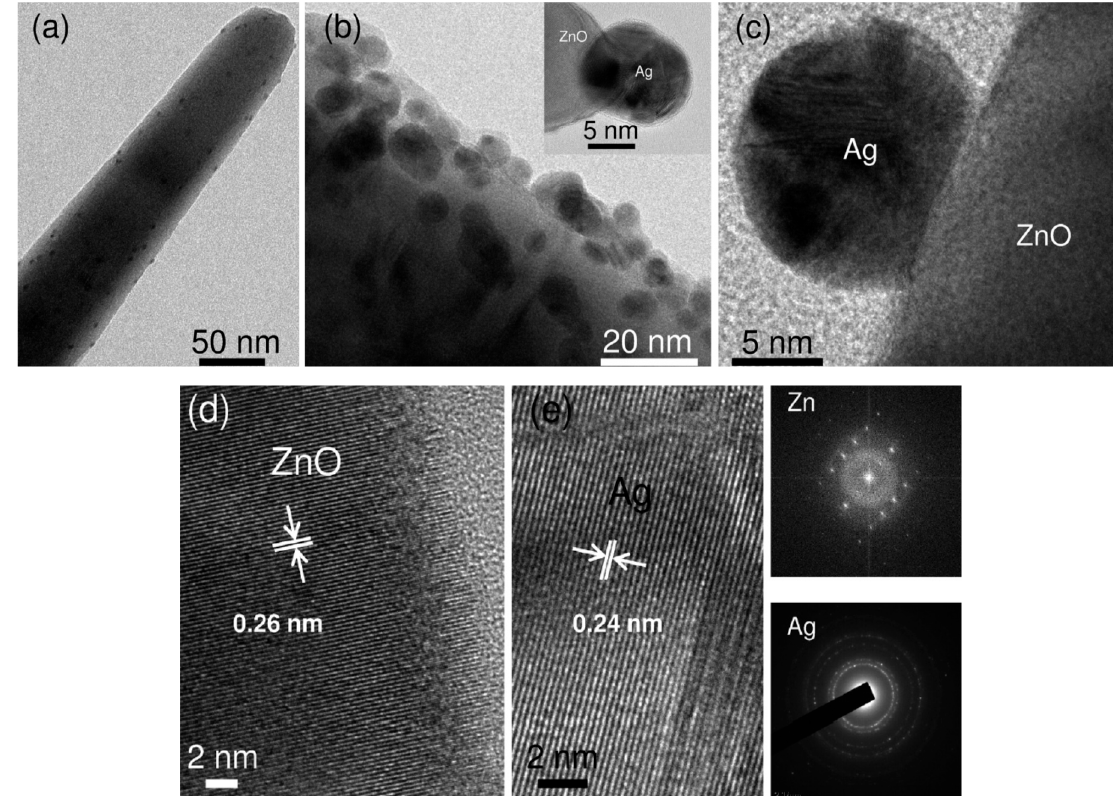
Figure 20. TEM images of ( a ) a single ZnO nanorod with uniformly dispersed AgNPs. ( b ) Side view of AgNPs/ZnO nanorod and immobilized AgNP at the tip of ZnO (inset). High-resolution TEM (HRTEM) images showing ( c ) a clear interface between AgNP and ZnO, ( d ) lattice fringes with characteristic d-spacing of ZnO, and ( e ) lattice fringes of AgNP. The corresponding electron diffraction patterns of ZnO (above panel) and AgNP (below panel) are also presented. Reproduced from [235] under a Creative Commons Attribution 3.0 Unported License.